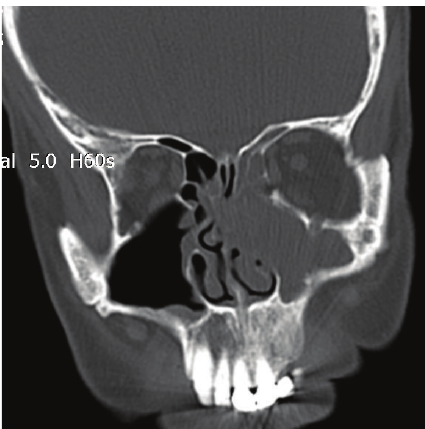
Figure 1: Paranasal sinus computed tomography showing a soft tissue lesion eroding the left maxillary sinus medial wall, filling the ethmoidal cells and frontal sinus and destructing the lamina